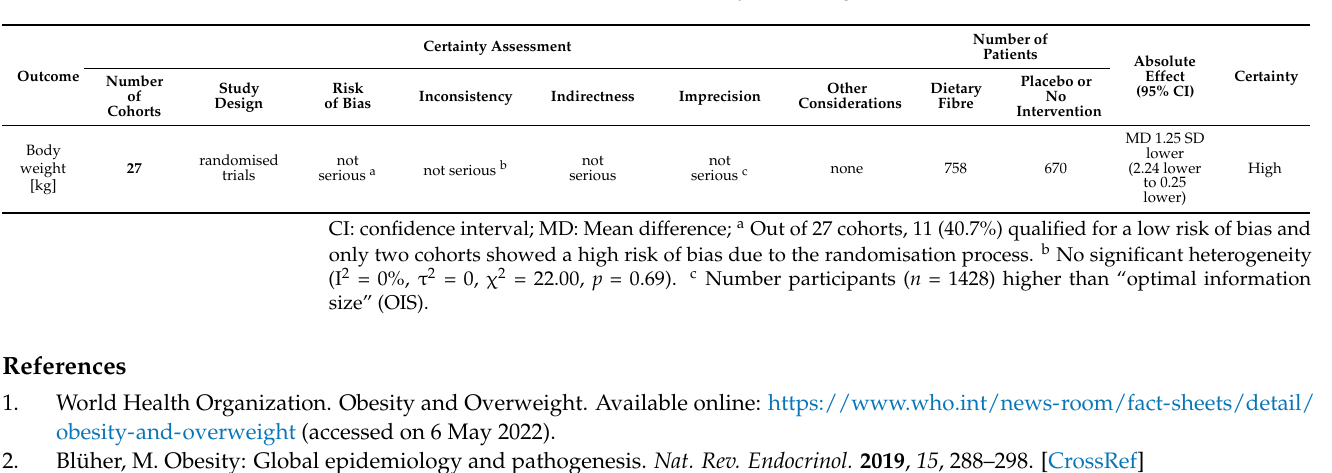
Table A1. Estimation of evidence certainty according to GRADE